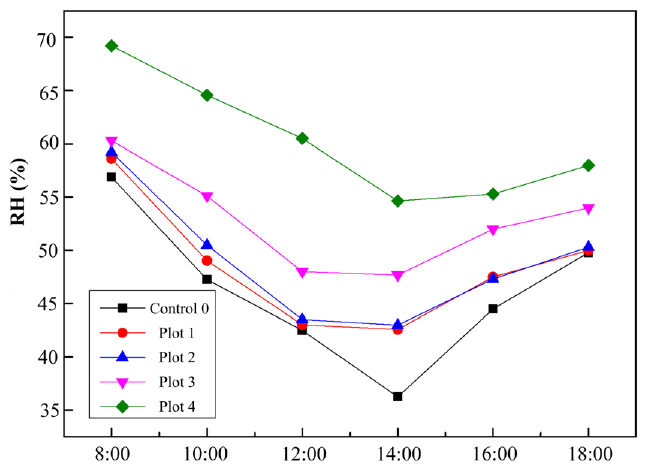
Figure 3. Relative humidity changes at different